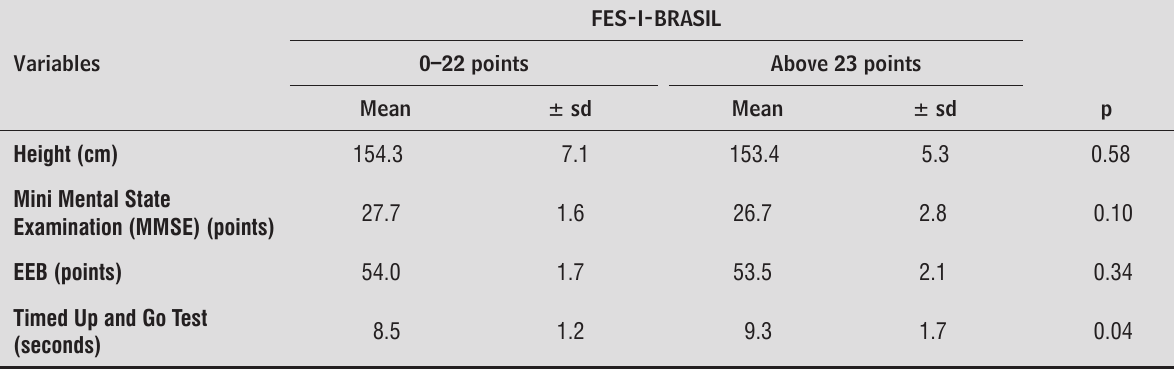
Table 2 - Mean and standard deviation (± sd) of the independent variables according to self-efficacy of falls in the Community-dwelling elderly women of Natal, RN, 2012